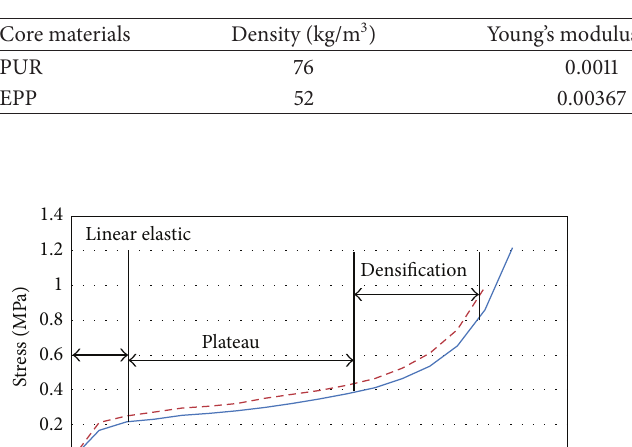
Table 3: Properties of crushable foams.